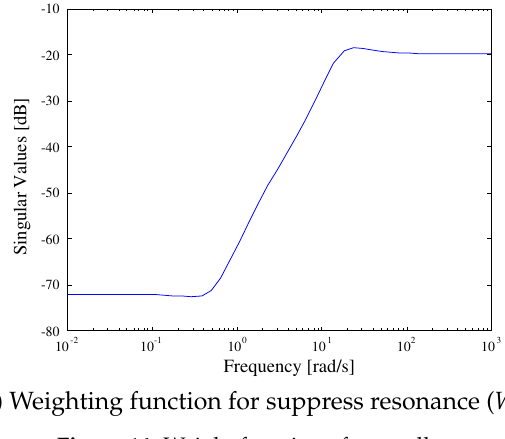
Figure 14. Weight function of